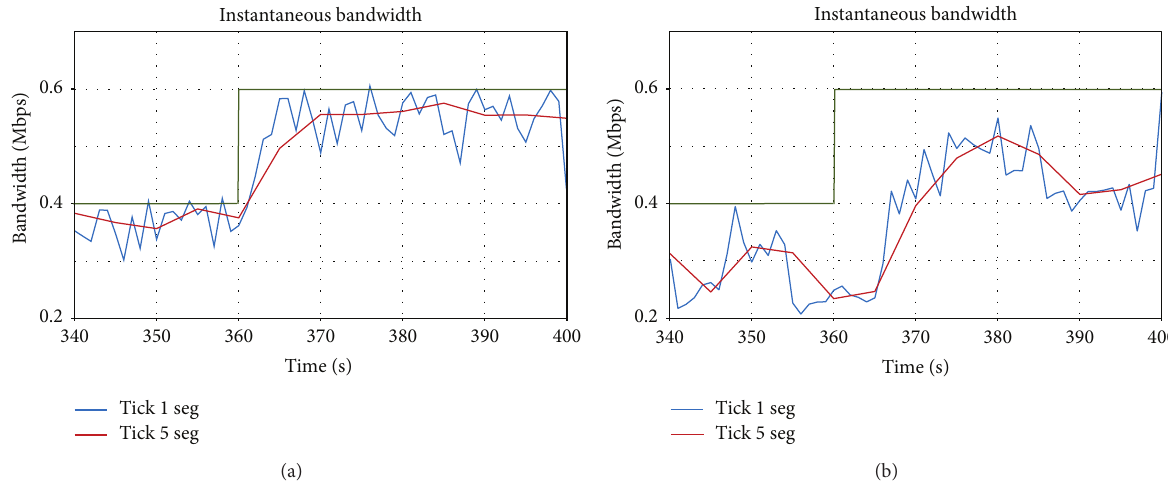
Figure 9: Instantaneous bandwidth of Vidyo with (a) bandwidth limitations in the uplink; (b) bandwidth limitations in the